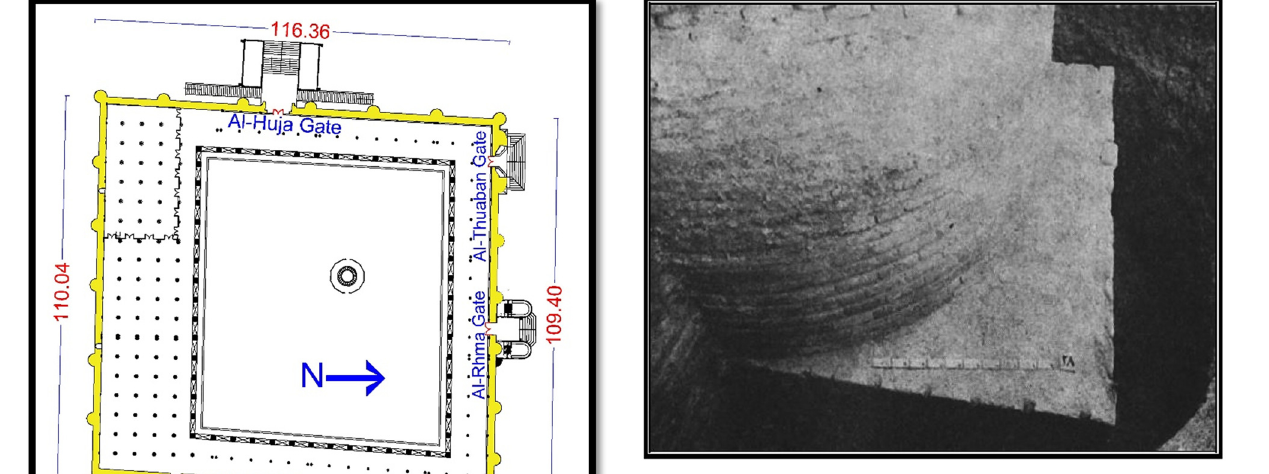
Plate 2: The foundation of a tower in Al - Kufa Mosque according to the archaeological investigation in